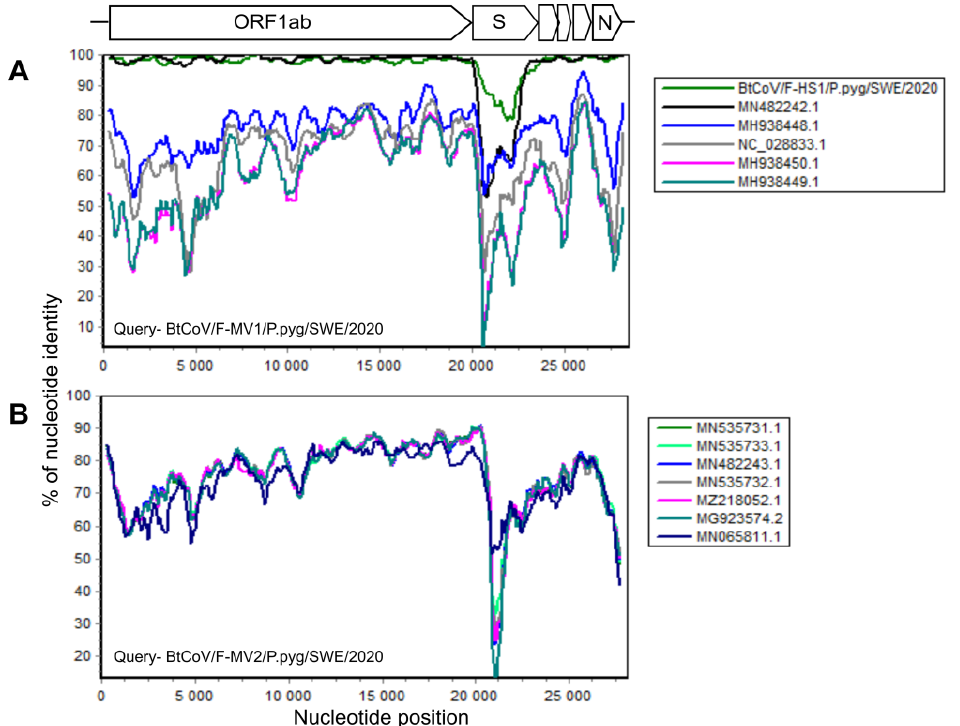
Figure 2. Simplot analysis of Swedish bat coronaviruses. Near full-length sequences of BtCoV/F- MV1/P.pyg/SWE/2020 ( A ) and BtCoV/F-MV2/P.pyg/SWE/2020 ( B ) were used as queries and com- pared with closest reference sequences in the SimPlot similarity analysis. All the analyses were per- formed with a Kimura model, a window size of 600 base pairs, and a step size of 100 base pairs.